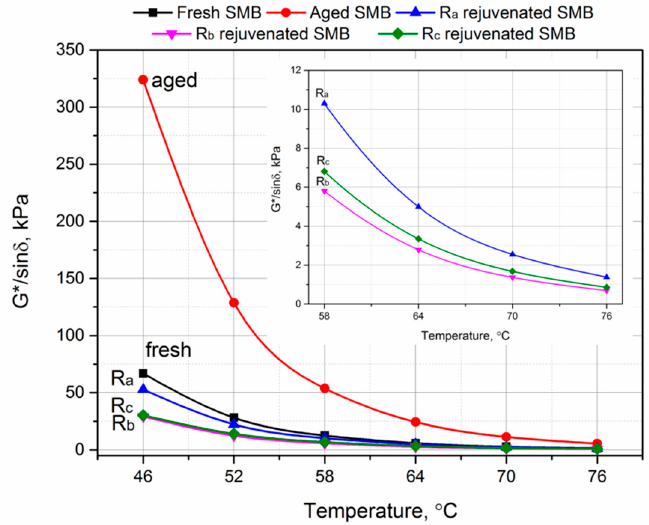
Figure 8. Rutting factor (G*/sin δ ) of fresh, aged, and rejuvenated SMB versus temperature.